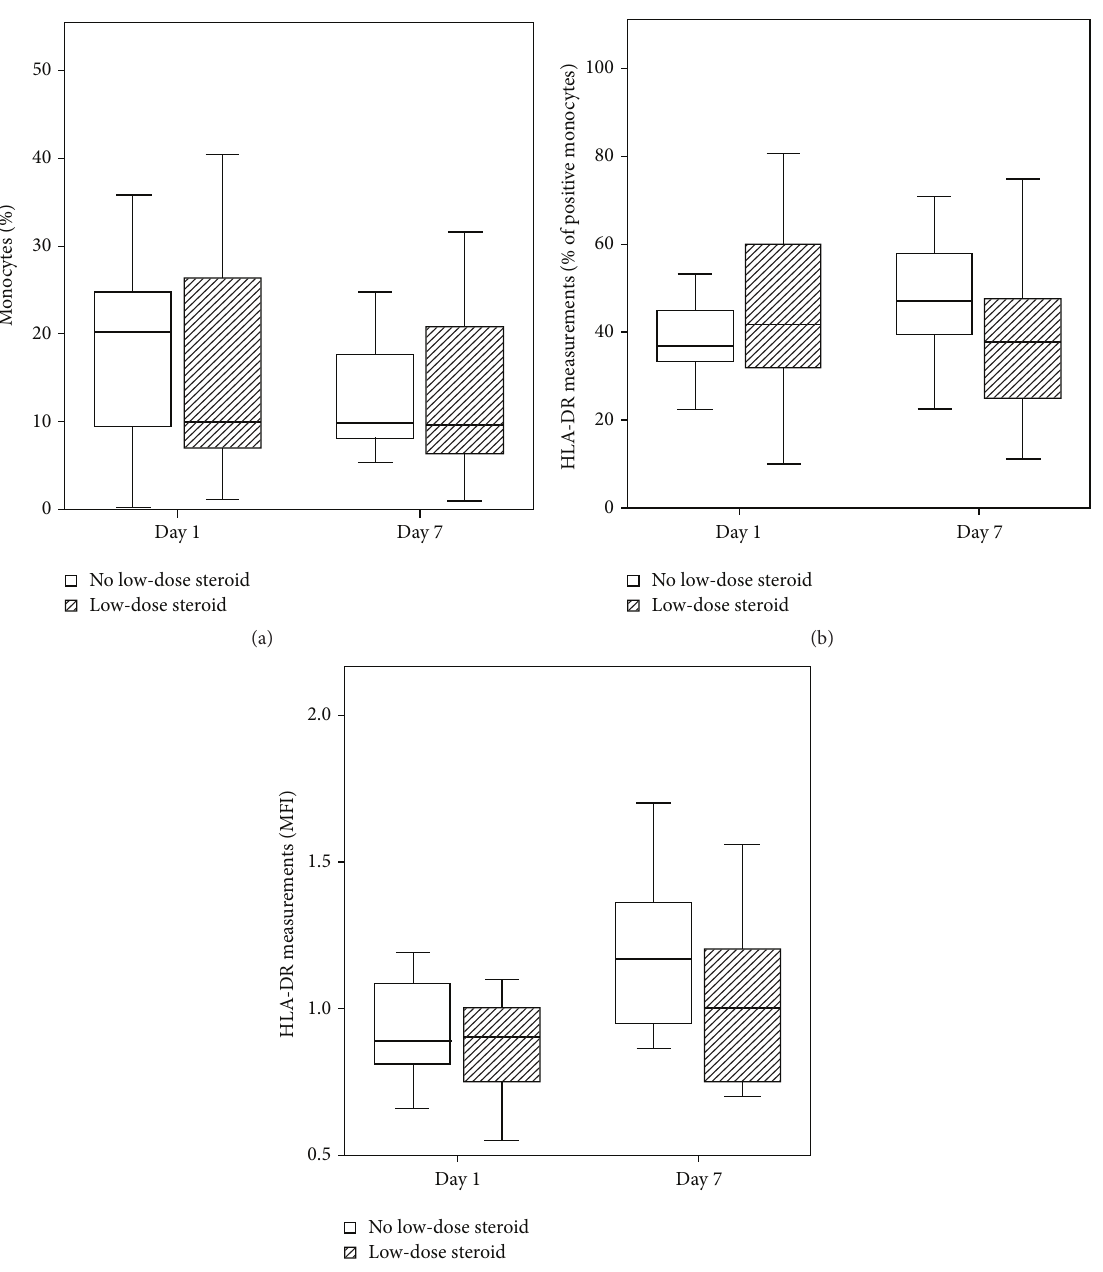
Figure 2: No change of HLA-DR expression between groups of no low-dose steroid and low-dose steroid. Boxplots of (a) monocyte percentage, (b) positive HLA-DR percentage in monocytes, and (c) MFI of HLA-DR are shown in patients treated with or without low-dose steroid therapy on days 1 and 7. HLA= human leukocyte antigen; MFI= means of fluorescence